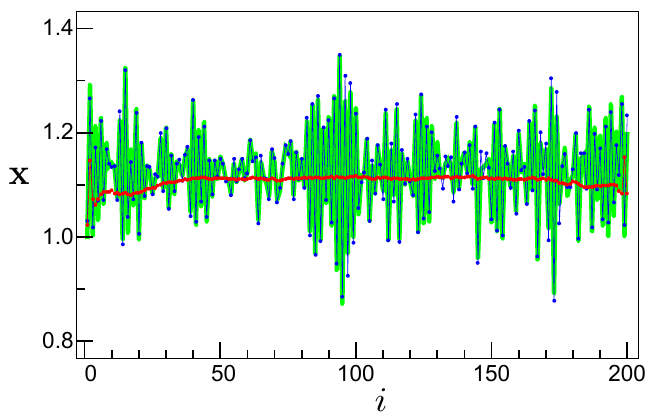
Figure 8: Typical time-series x generated by model (13) (green) compared against the reconstruction by the ENCA-decoder, using three (red) or four (blue) latent variables. The contribution of the additional statistic is indisputable. The data has not previously been used for training the